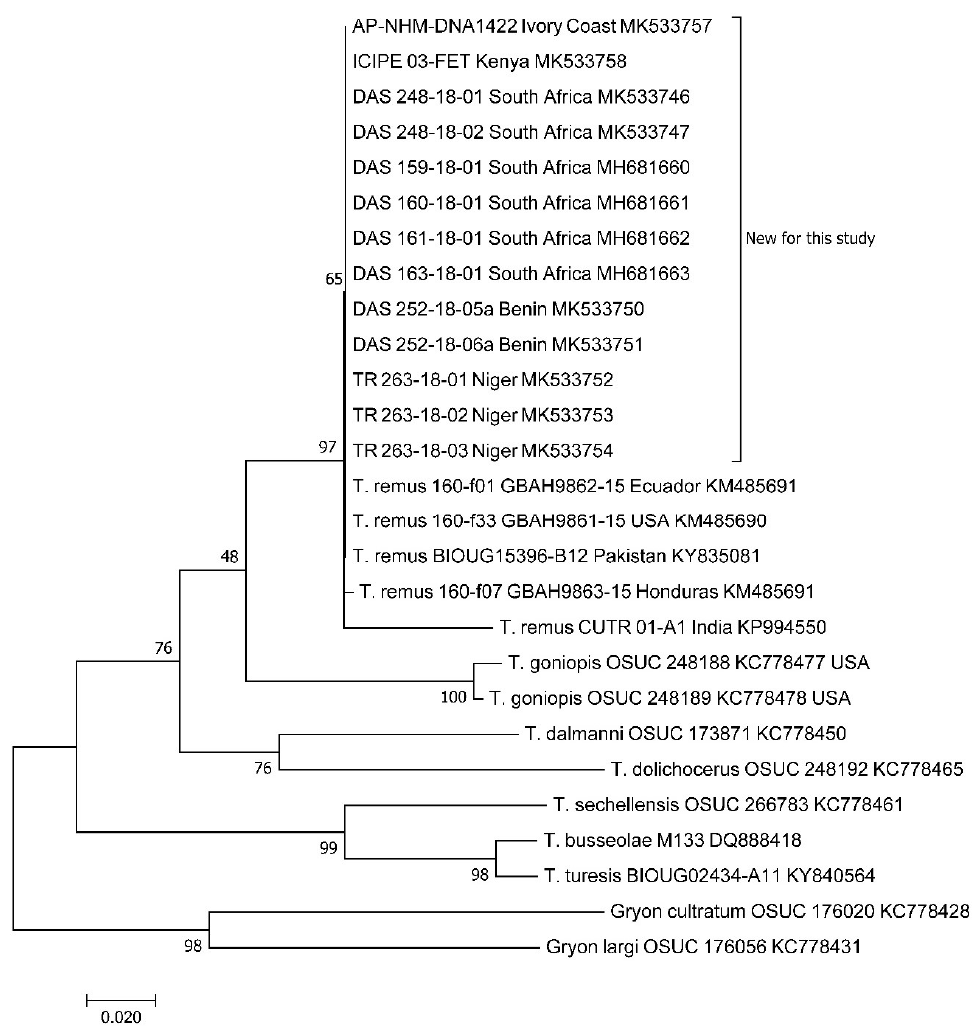
Figure 1. Molecular Phylogenetic analysis of Telenomus remus and related species by maximum likelihood method. The tree with the highest log likelihood (-1910.13) is shown. The percentage of trees in which the associated taxa clustered together is shown next to the branches. The analysis involved 27 nucleotide sequences. There were a total of 382 positions in the final dataset. The 13 specimens analysed in this study are indicated as “New for this study”, and their codes are indicated in Table 1.